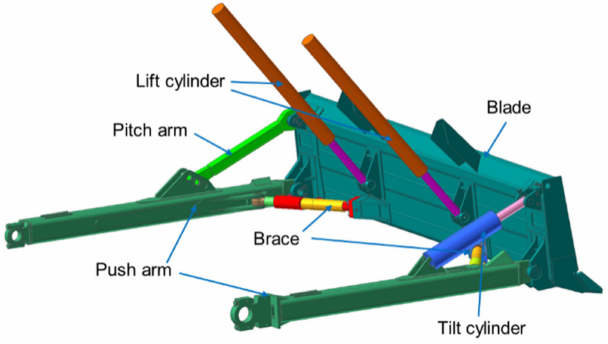
Figure 1. Working device of the